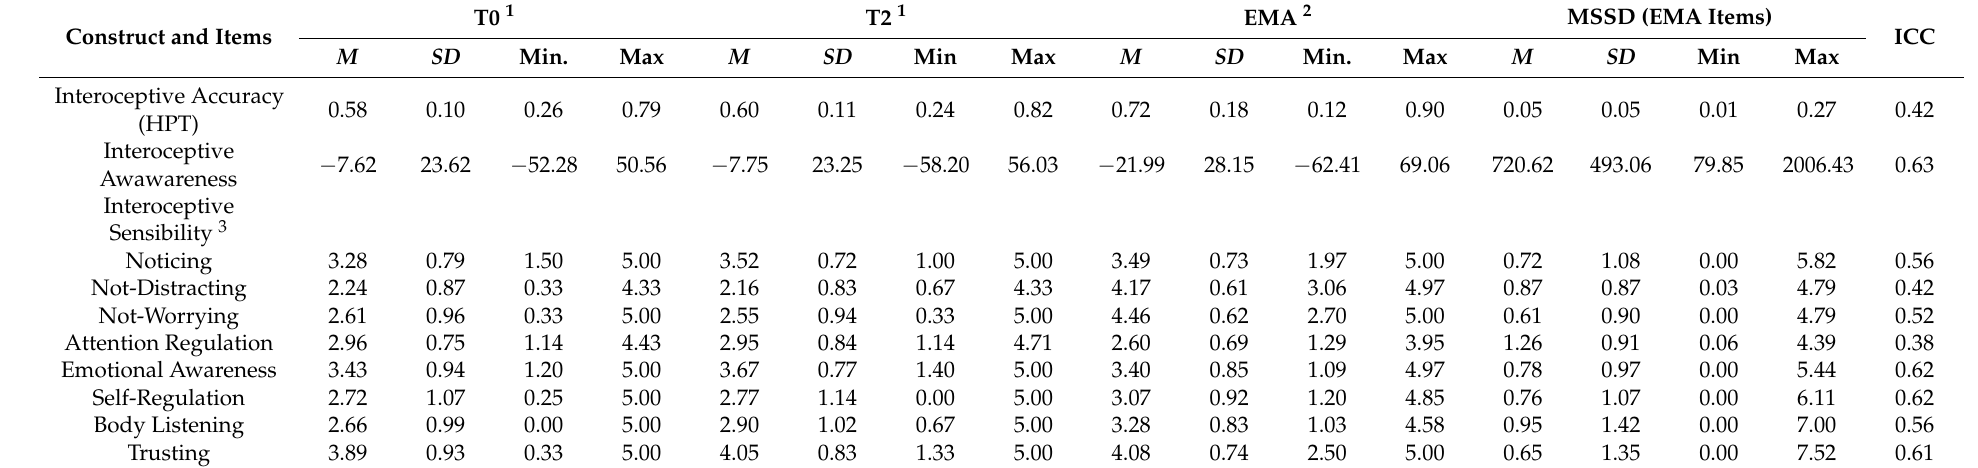
Table 1. Descriptive statistics and variability indices of baseline, post and ecological momentary